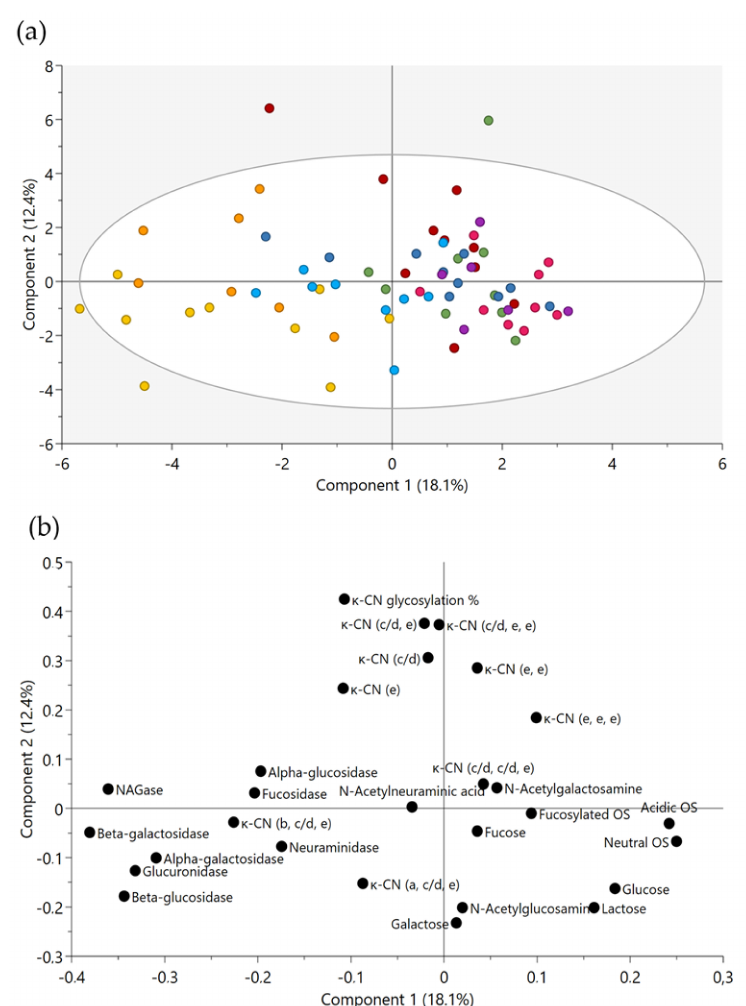
Figure 4. Principal component analysis (PCA) of the first two principal components. The PCA model includes relative abundances of neutral, acidic and fucosylated oligosaccharides (OS), nine GMP glycoforms ((e), (c/d), (e, e), (c/d, e), (c/d, e, e), (e, e, e), (b, c/d, e), (a, c/d, e) (c/d, c/d, e)), GMP glycosylation degree (%), six monosaccharides (fucose, galactose, glucose, N -acetyl-galactosamine (GalNAc), N -acetyl-glucosamine (GlcNAc), sialic acid), lactose and eight glycosidases ( N - acetyl- β -glucosaminidase, β -glucuronidase, α -fucosidase, β -galactosidase, α -galactosidase, α -glucosidase, β -glucosidase, N -acetyl- α -neuraminidase). ( a ) Scores plot illustrating individual cows from each breed; Western Finncattle (WFC, pink), Norwegian Doela cattle (DOL, green), Eastern Finncattle (EFC, dark blue), Swedish Mountain cattle (SMC, purple), Icelandic cattle (IC, red), native Lithuania Black and White cattle (LT, yellow), Danish Red anno 1970 (RDM-70, light blue) and Norwegian Telemark cattle (TM, orange) ( n = 70) and ( b ) corresponding loading